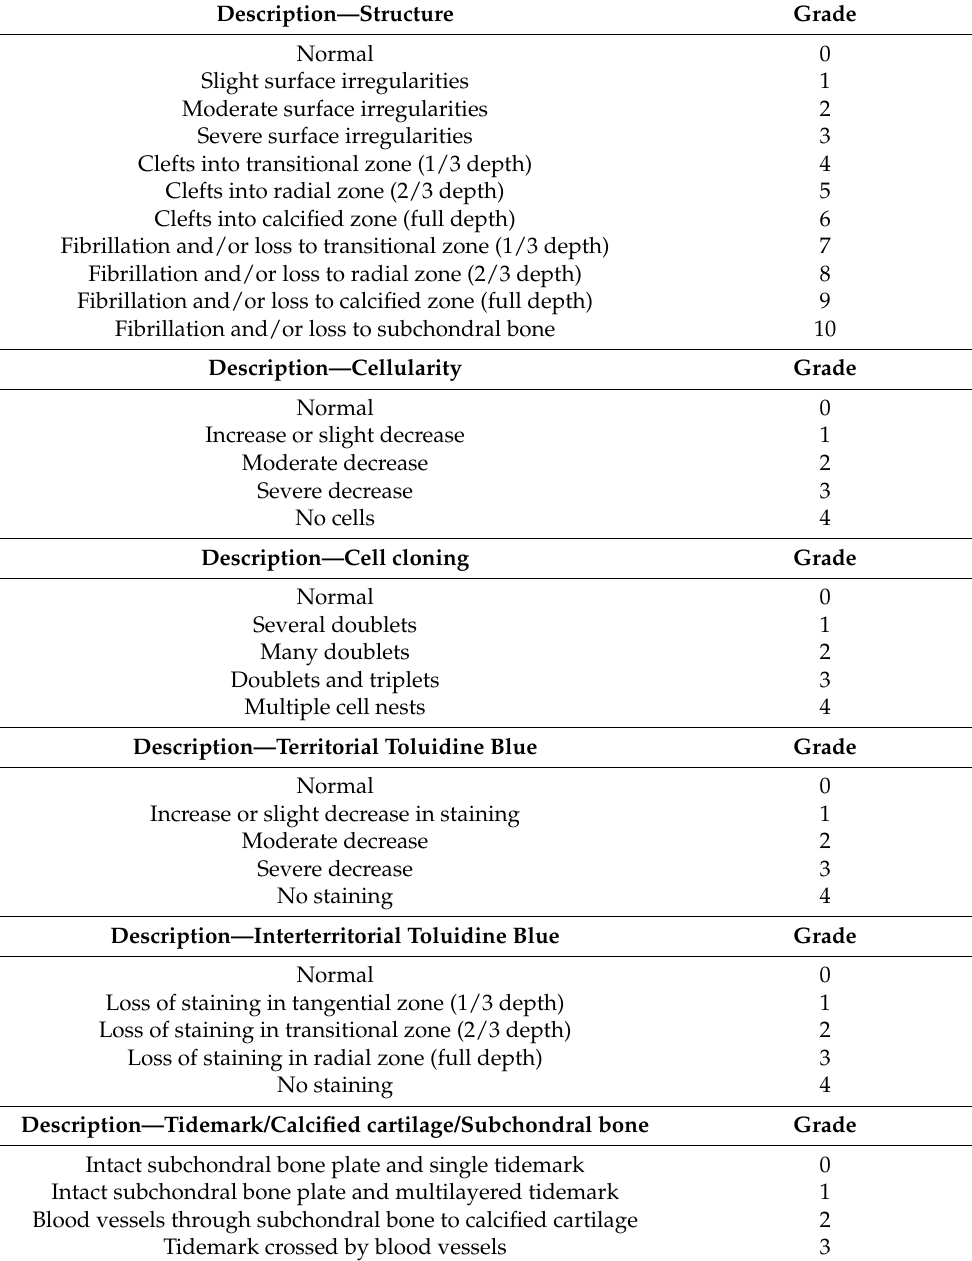
Table A3. Scoring according to the Little score scale for osteochondral tissue (i.e., Zones 2 and 3). The score was used to evaluate the chondral and subchondral tissue surrounding the defect according to structure, cellularity, cell cloning, territorial, and interterritorial Toluidine Blue staining, as well as the tidemark, calcified cartilage, and subchondral bone